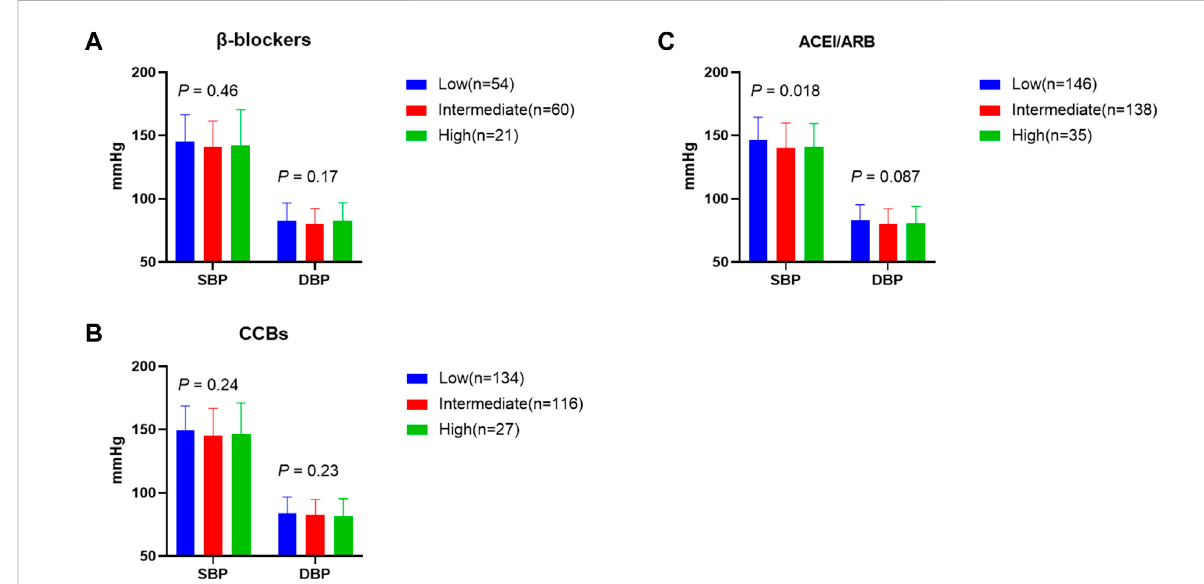
FIGURE 2 Effect of the TRIB3 promoter 33 bp VNTR on antihypertensive drugs. Data are shown as mean ± SD, P values were calculated from one-way ANOVA with adjustments for sex, age and BMI. ACEI/ARB, angiotensin converting enzyme inhibitors/angiotensin receptor blockers; CCBs, calcium channel blockers; SBP, systolic blood pressure; DBP, diastolic blood pressure; Low means low number of 33 bp tandem repeats (repeats < 6); Intermediate means intermediate number of 33 bp tandem repeats (repeats > 6, ≤ 8); High means high number of 33 bp tandem repeats (repeats >